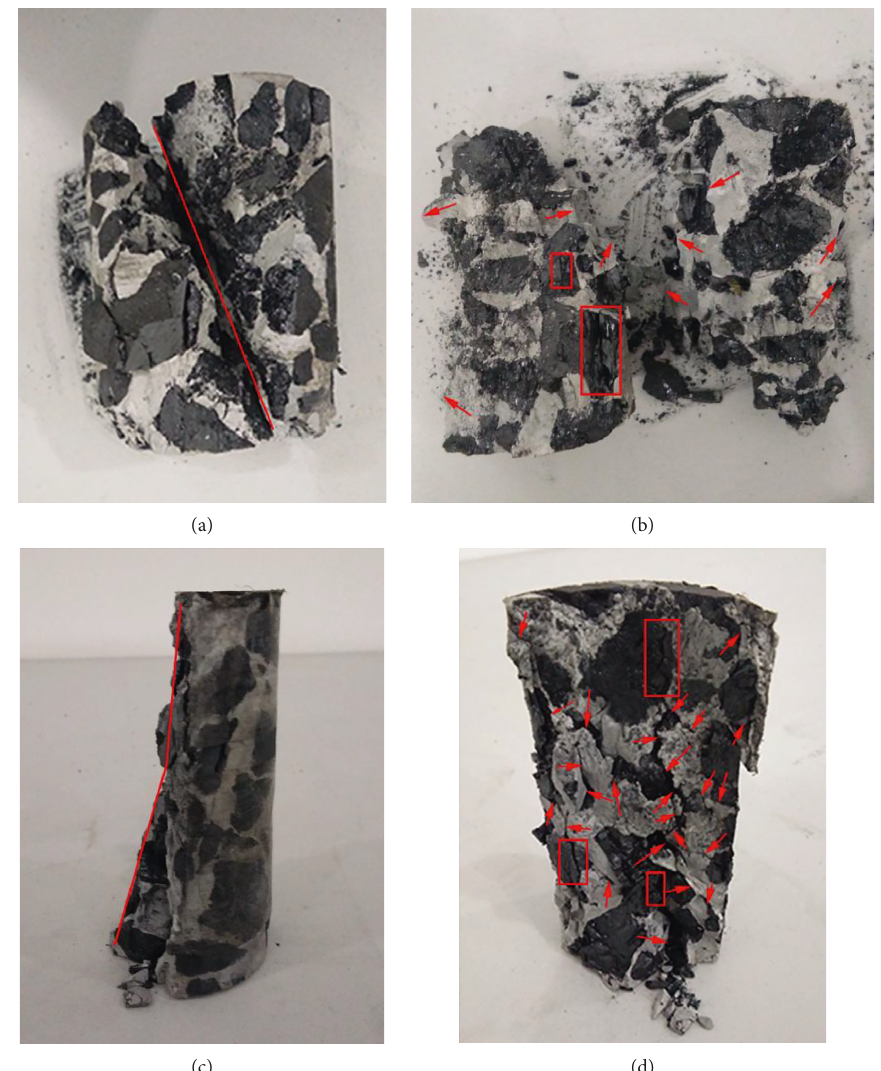
Figure 11: Ultimate failure of the medium specimens under the confining pressure of 5 MPa and 15MPa, respectively. Fracture profiles: (a) 5MPa; (c) 15 MPa. Crack distribution: (b) 5MPa; (d)